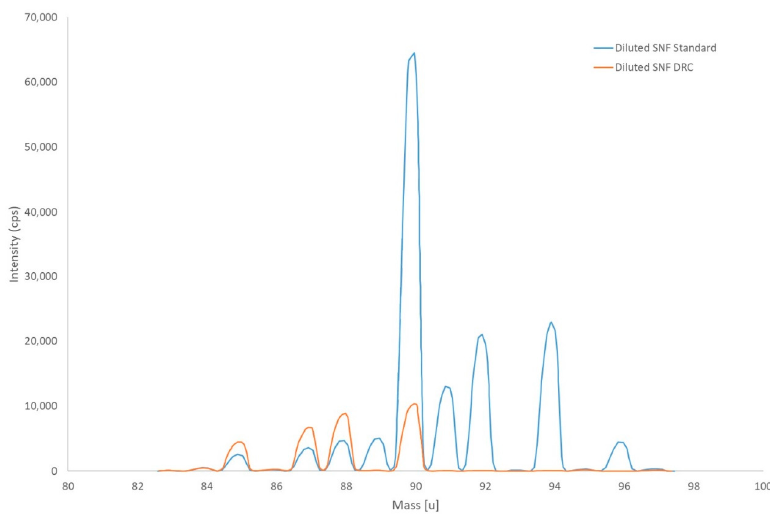
Figure 4. Mass spectra (from 84 till 100 u) of a diluted leachate sample; the blue spectrum shows predominantly natural Zr isotopes (90, 91, 92, 94, 96); and the presence of fission 88 Sr as ( 88 Sr/ 86 Sr)meas is much bigger than ( 88 Sr/ 86 Sr)nat. The orange spectrum shows only the Sr isotopes and the near elimination of Zr isotopes when using the dynamic reaction cell (DRC). Molecules 2020 , 25 , x Standard working solutions of strontium and zirconium were measured using the SeaFAST system with ICP-DRC-MS detection. Figure 5 shows the elution profile of Sr in the presence of 100 times more Zr. In the direct mode (Figure 5, A) the effect of the use of O 2 in the DRC can be observed but even if the efficiency of the reaction between Zr and O 2 reaches 99.9%, the isobar m / z 90 is still present. In pre-concentration mode, the comparison of the elution profiles reveals the different behavior between Sr and Zr in the Sr-resin column. Sr is retained while Zr is eliminated along with the other components of the matrix (Figure 5, B). Similar results have been obtained using nuclear spent fuel leachate analogues samples. Interference free determination of 90 Sr concentrations in the samples can be only achieved using the combination of matrix removal and DRC.